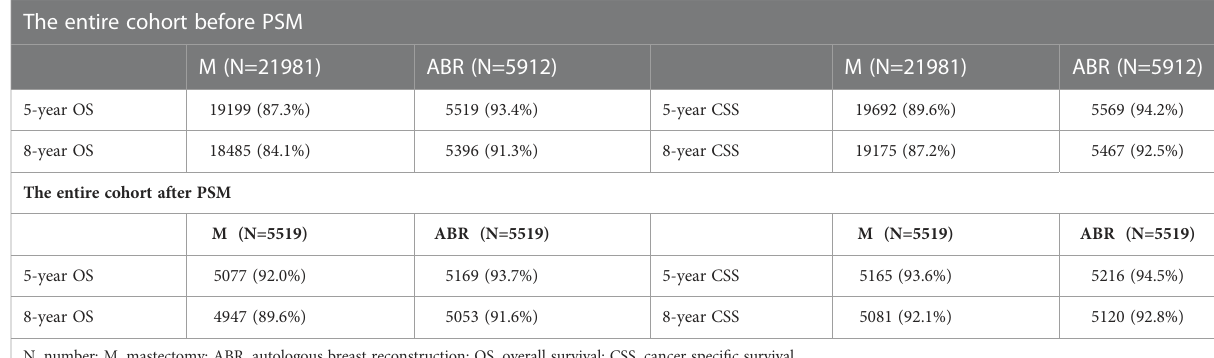
TABLE 2 The 5-and 8-year OS and CSS rates of BC